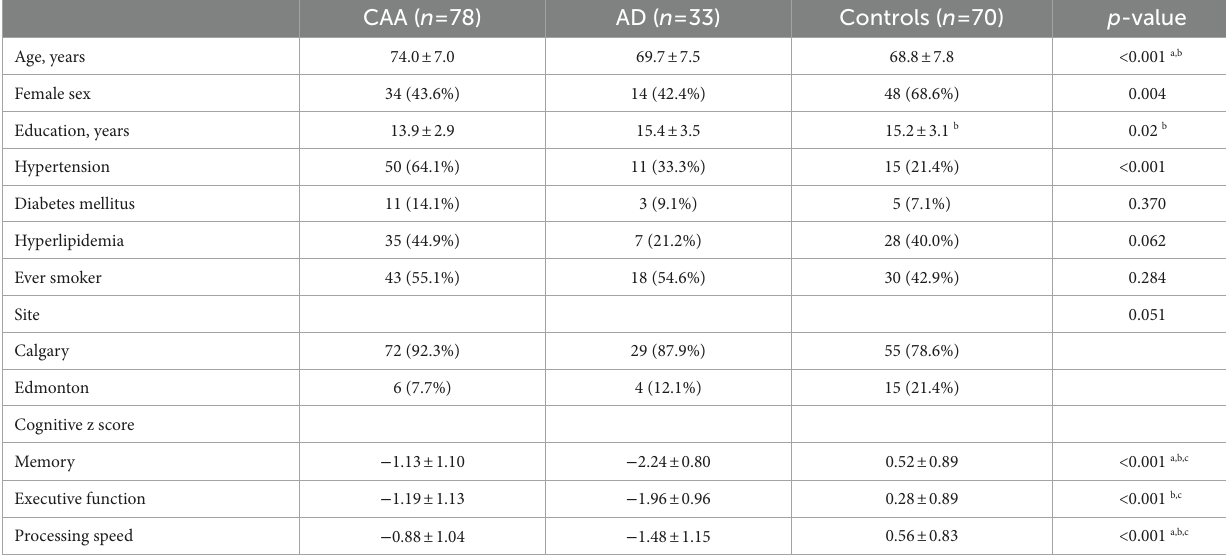
TABLE 1 Characteristics of included participants.